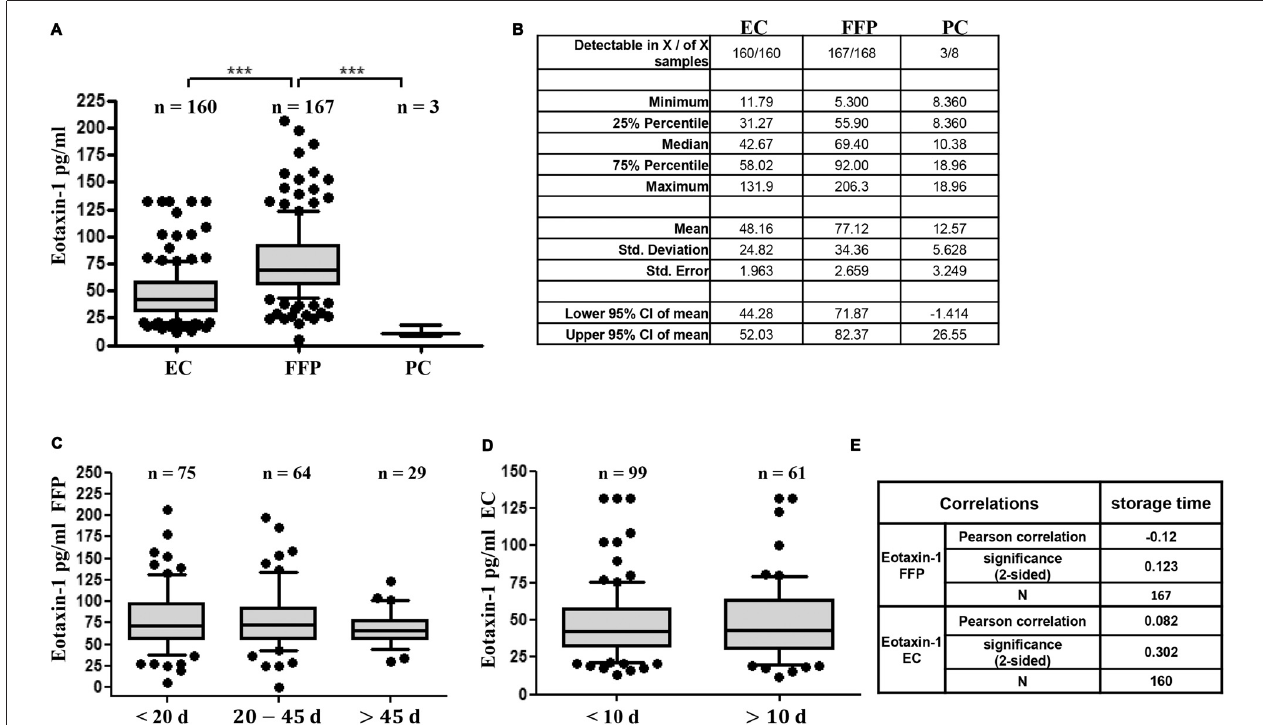
FIGURE 1 | Eotaxin-1 is detectable and stable in fresh-frozen plasma (FFP) and erythrocyte concentrate (EC), but not in platelet concentrate (PC). (A,B) Eotaxin-1 was measured in EC, FFP and PC. (A) Data are presented as Box-Whiskers Plot, showing median and 10–90 percentiles. Statistical analysis was performed using Kruskal-Wallis one way analysis of variance (ANOVA) test including Dunn’s post hoc analysis ( ∗∗∗ p < 0.001). (B) Tabular summary and column statistics of EC, FFP, PC samples analyzed in (A) . (C,D) Eotaxin-1 was measured in (C) FFP and (D) EC and analyzed in dependence of storage time. Data are presented as Box-Whiskers Plot, showing median and 10–90 percentiles. (E) Pearson correlation analysis of eotaxin-1 in FFP and EC with storage